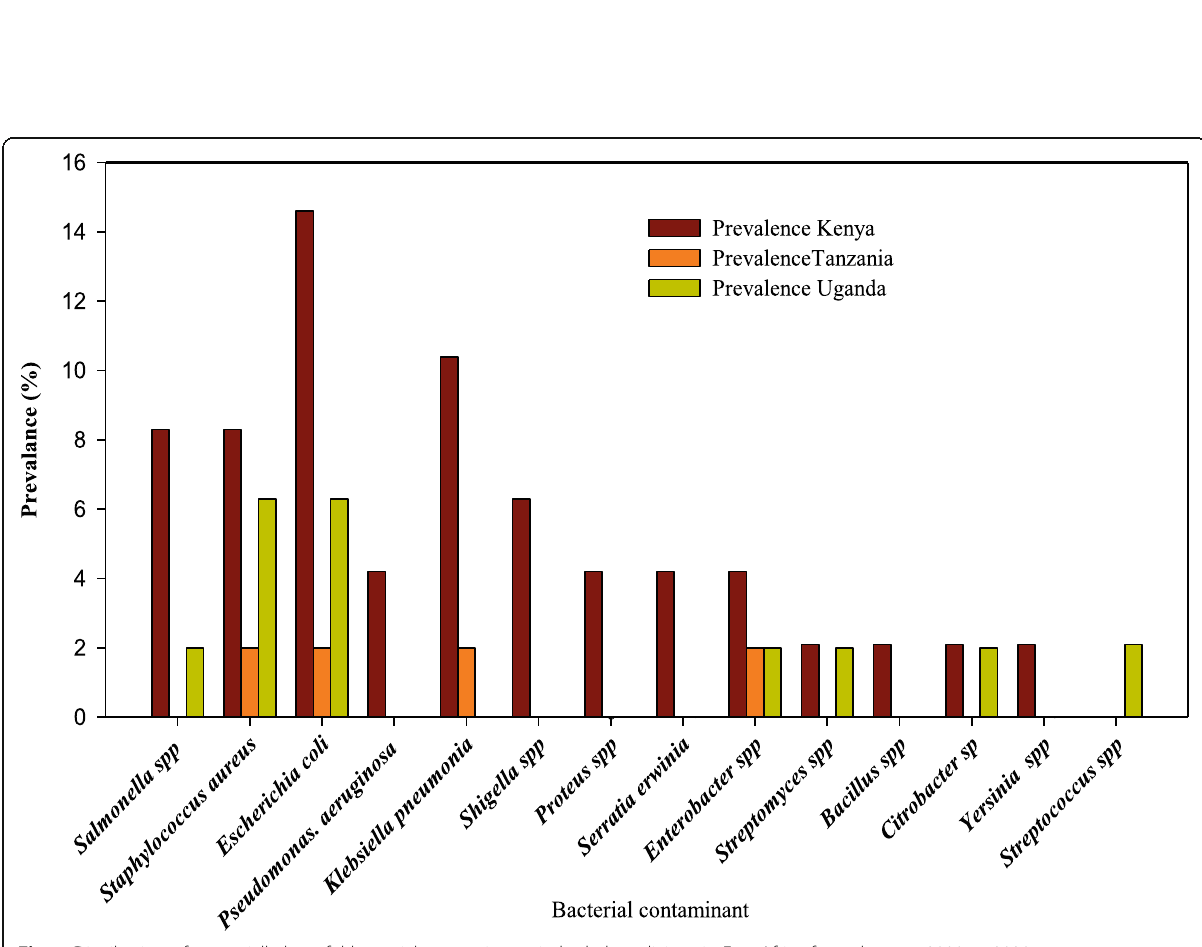
Fig. 4 Distribution of potentially harmful bacterial contaminants in herbal medicines in East Africa from the year 2000 to 2020